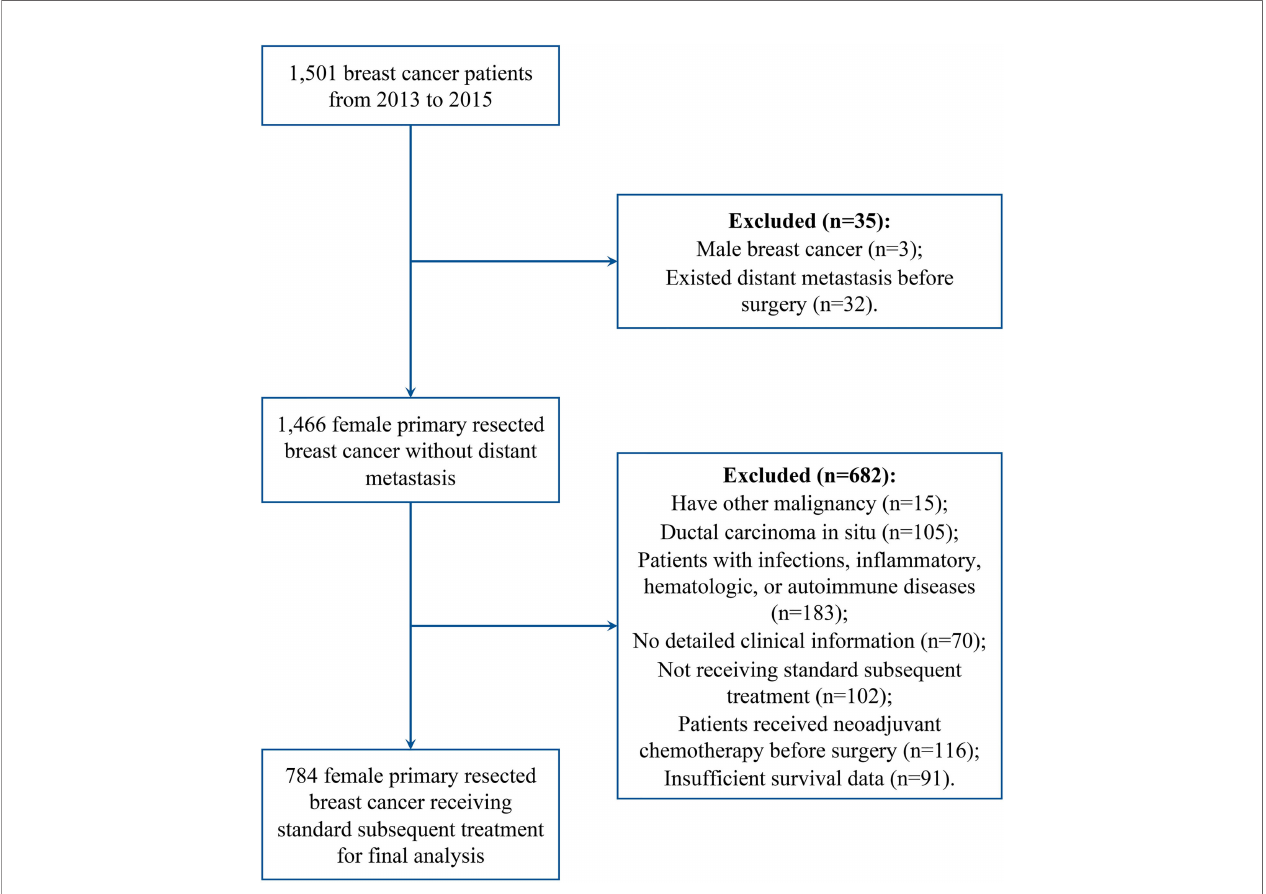
FIGURE 1 | Flow chart of patient